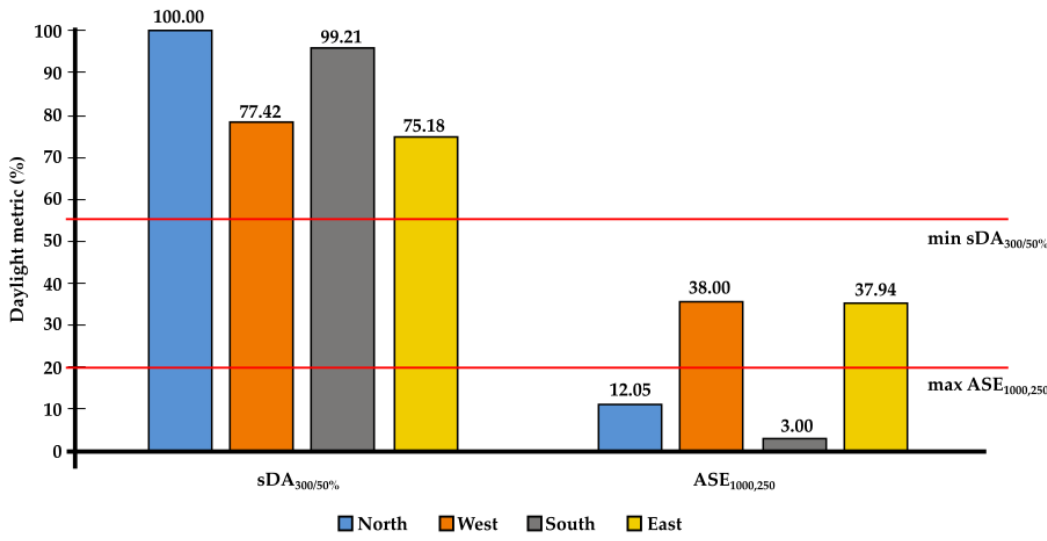
Figure 9. Annual simulation results in the fixed shading design option.